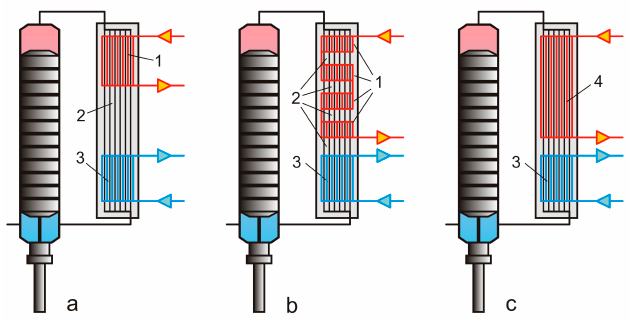
Figure 15. Bush-type engine design for isothermal ( a ) and non-isothermal heat supply ( b , c ): 1 —heater, 2 —regenerator, 3 —cooler, 4 —regenerative heater.